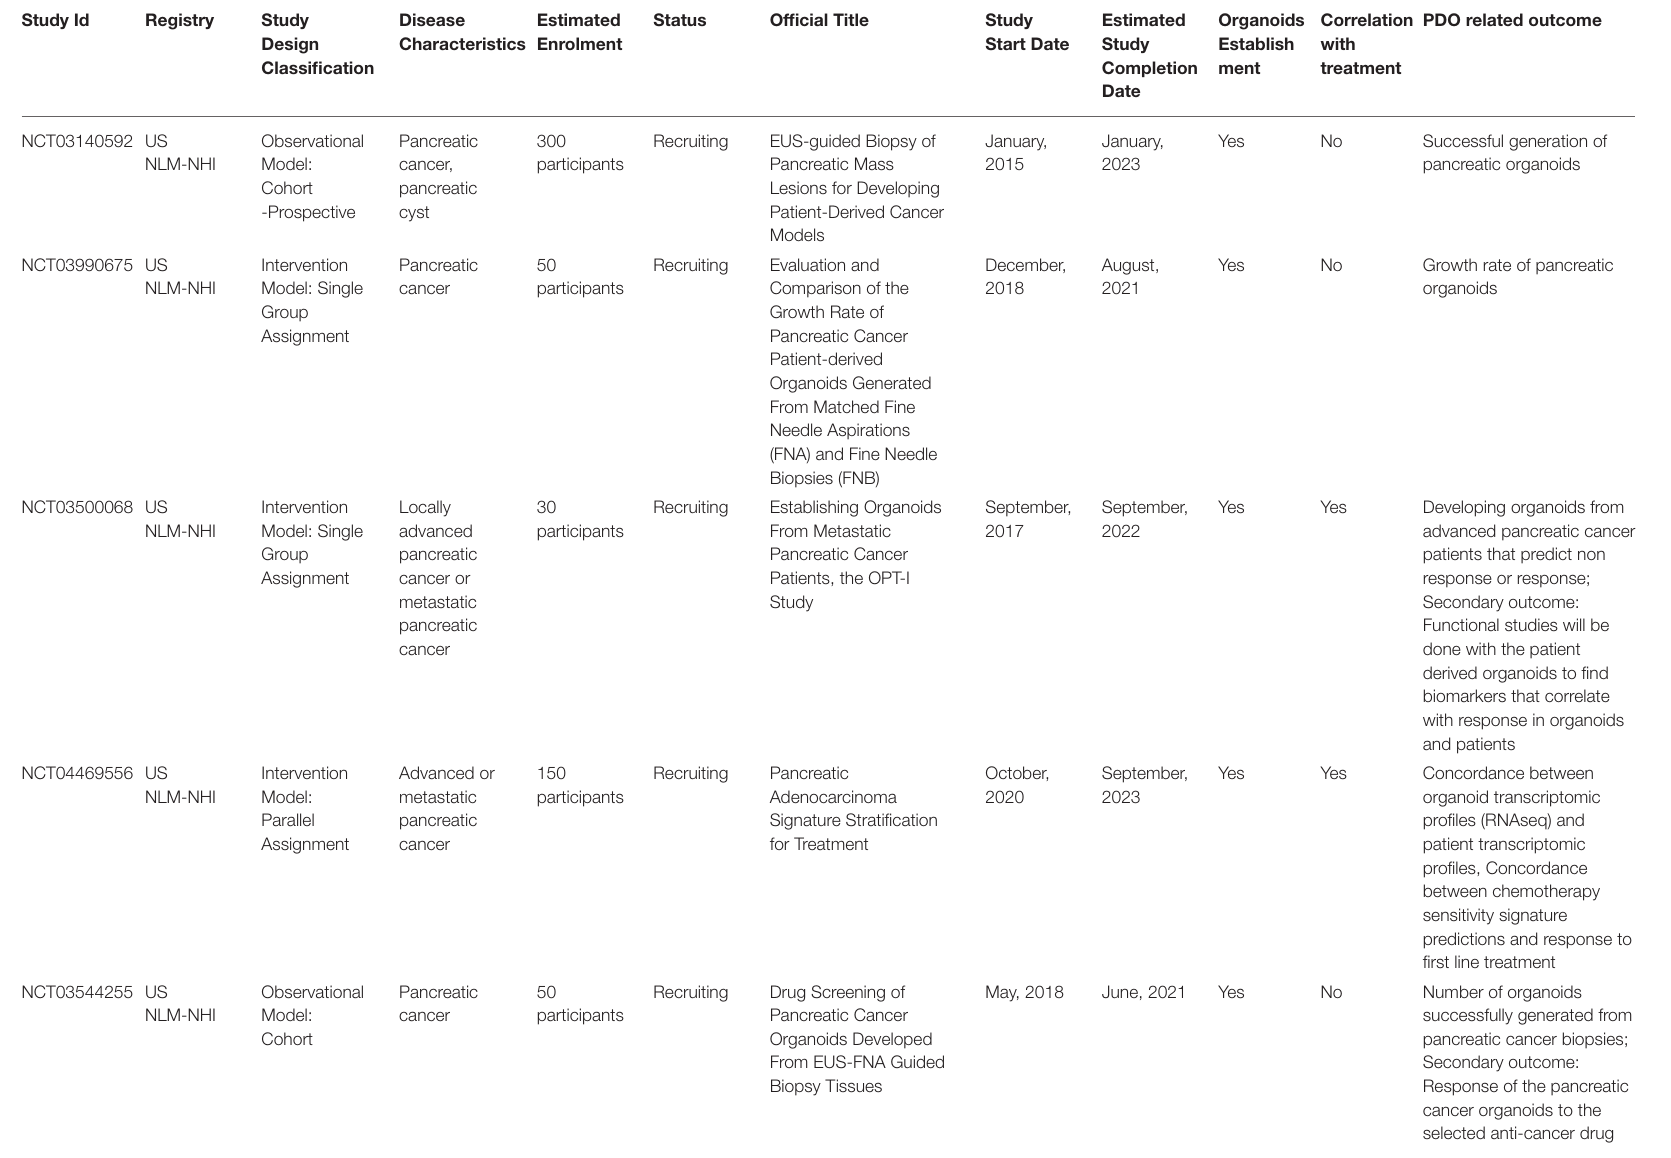
TABLE 1 | Clinical Trials employing pancreatic cancer